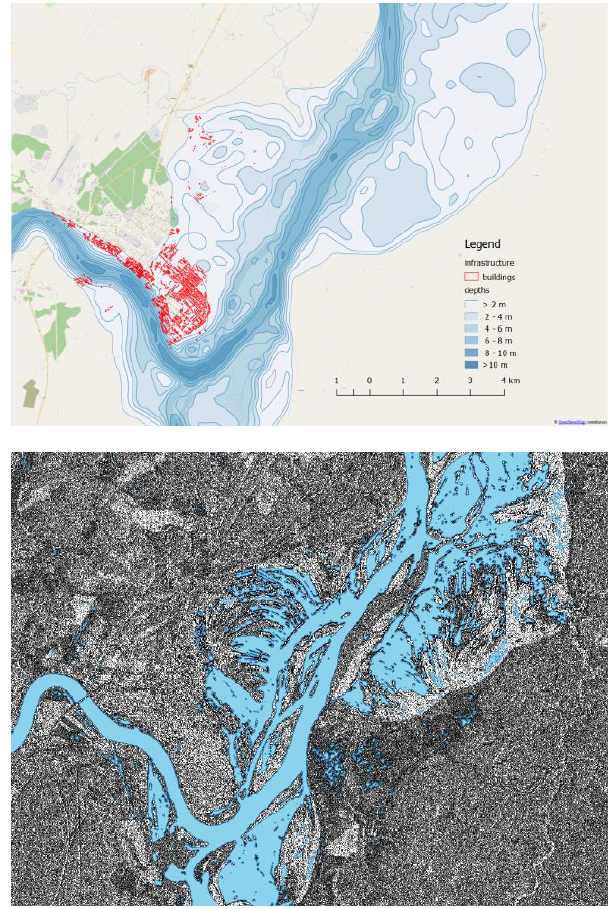
Figure 4. Comparison of simulation and remote sensing